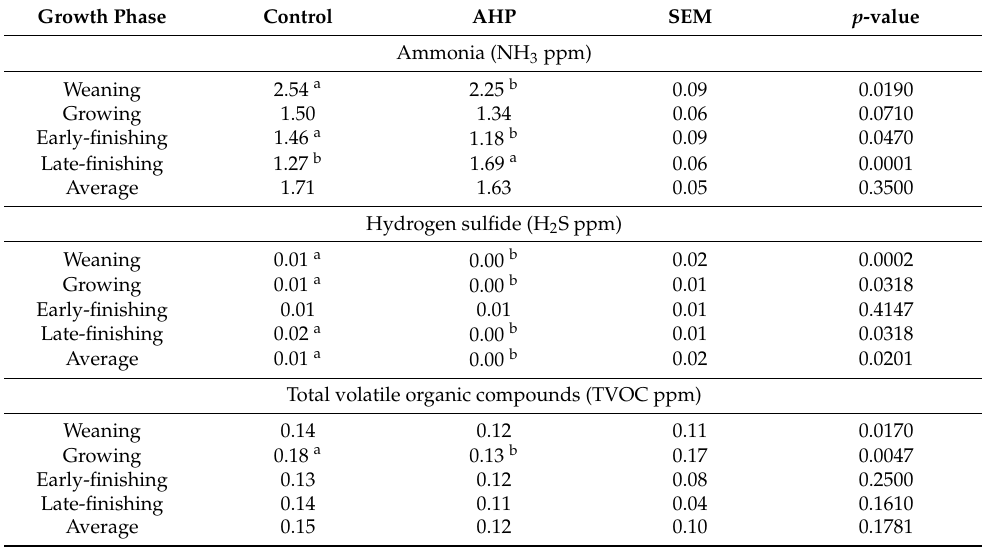
Table 3. Effects of the AHP cooling system on NH 3 (ppm) and H 2 S (ppm) concentrations in the pig house.